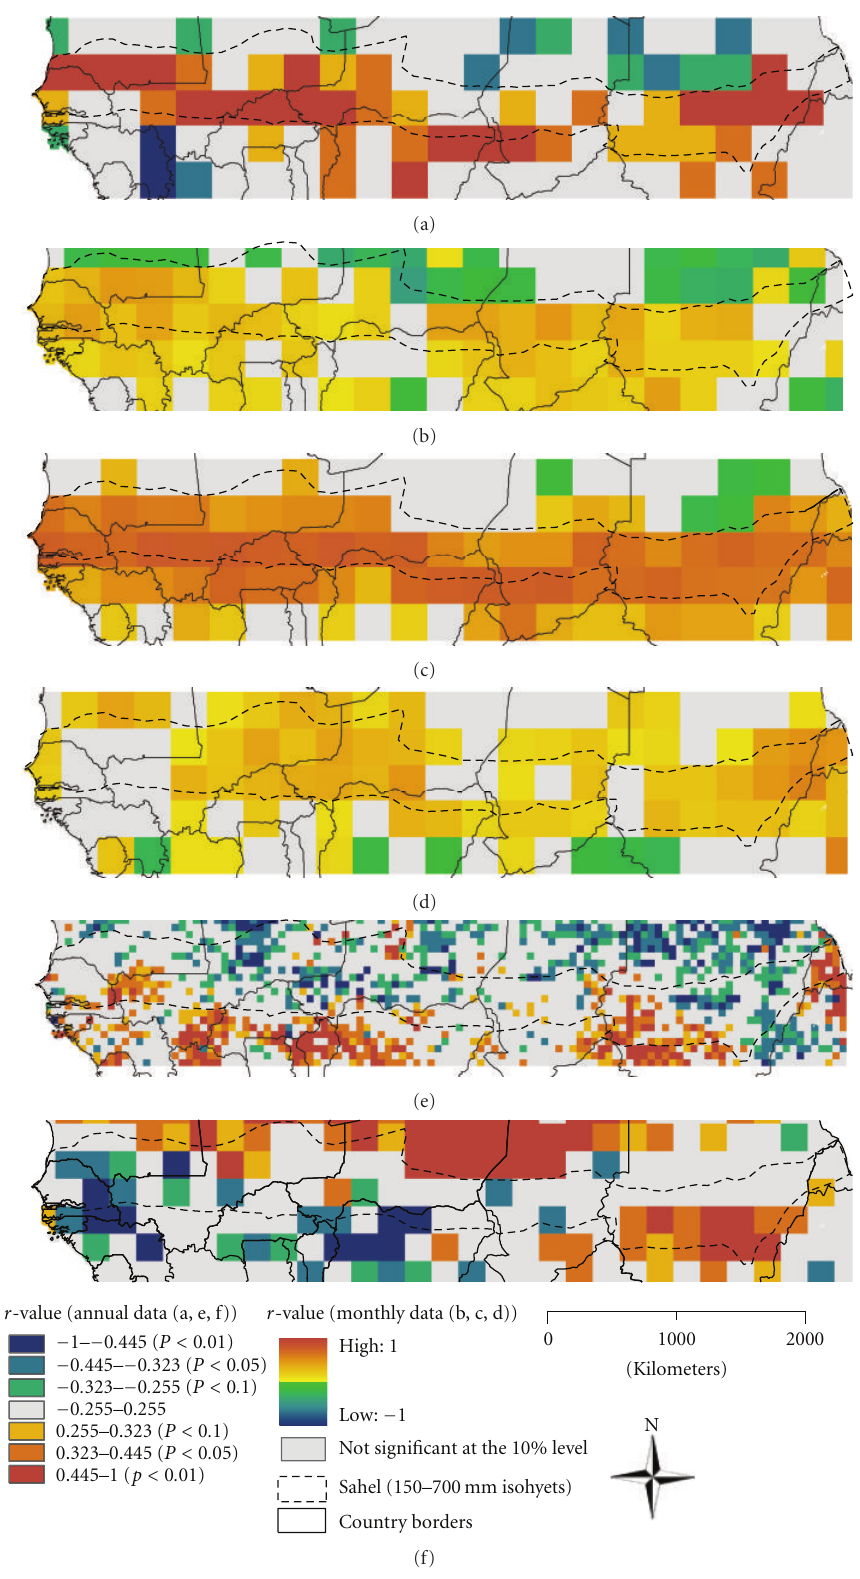
Figure 8: Annual correlations 1982–2007. (a) Annual NDVI/CMAP rainfall correlation. (b) Monthly GIMMS NDVI/CMAP rainfall correlation (June–October) no time lag. (c) Monthly GIMMS NDVI/CMAP rainfall correlation (June–October) one-month NDVI time lag. (d) Monthly GIMMS NDVI/CMAP rainfall correlation (June–October) two-month NDVI time lag. (e) Annual NDVI/air temperature correlation. (f) Annual NDVI/surface downward solar radiation flux